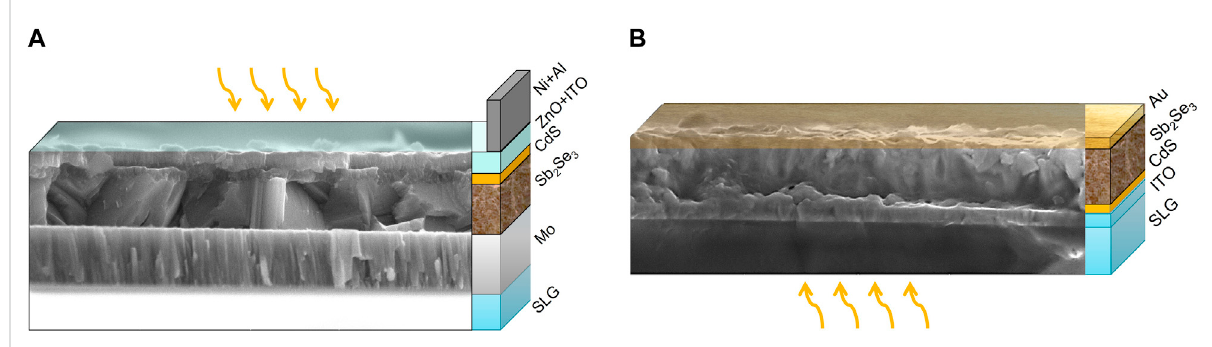
FIGURE 1 Standard planar (A) substrate and (B) superstrate con fi guration Sb 2 Se 3 solar